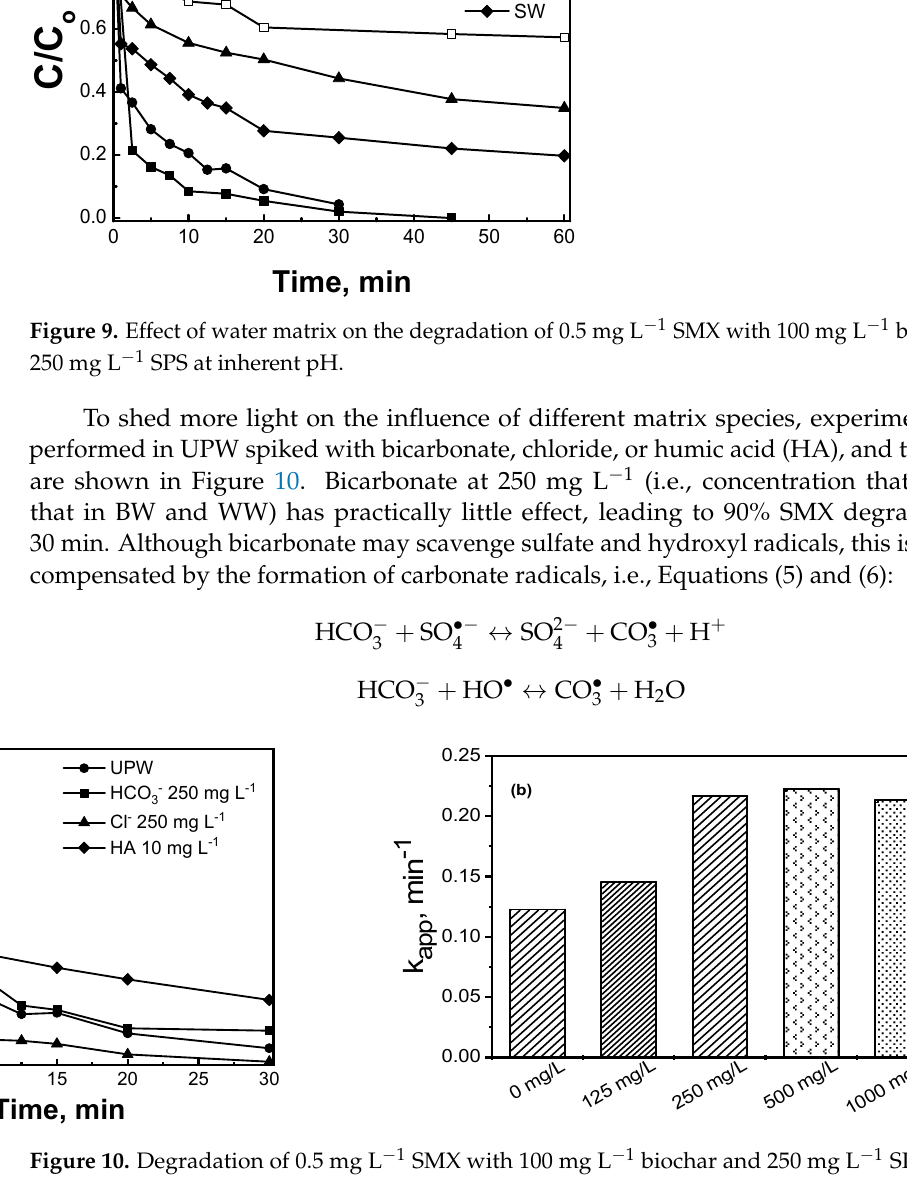
Figure 10. Degradation of 0.5 mg L − 1 SMX with 100 mg L − 1 biochar and 250 mg L − 1 SPS in UPW and inherent pH as a function of ( a ) spiked chloride, bicarbonate, or humic acid; ( b ) Chloride spiked at various concentrations.